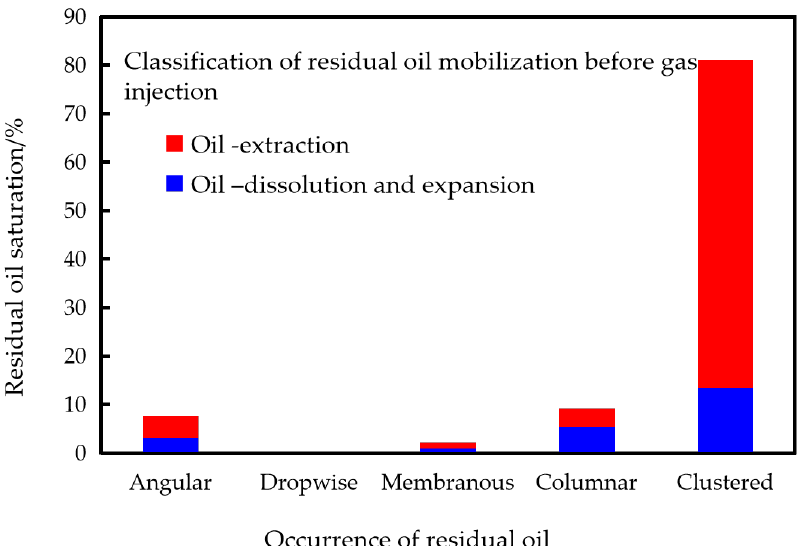
Figure 8. Mobilization classification of residual oil before gas injection .